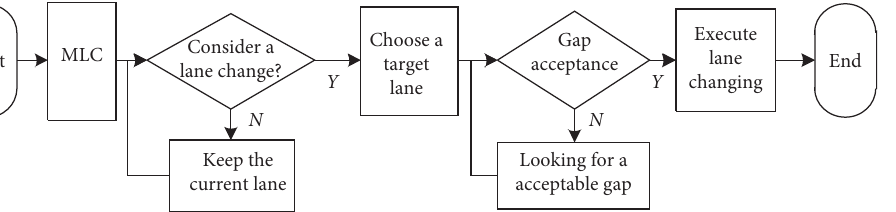
Figure 2: Lane-changing